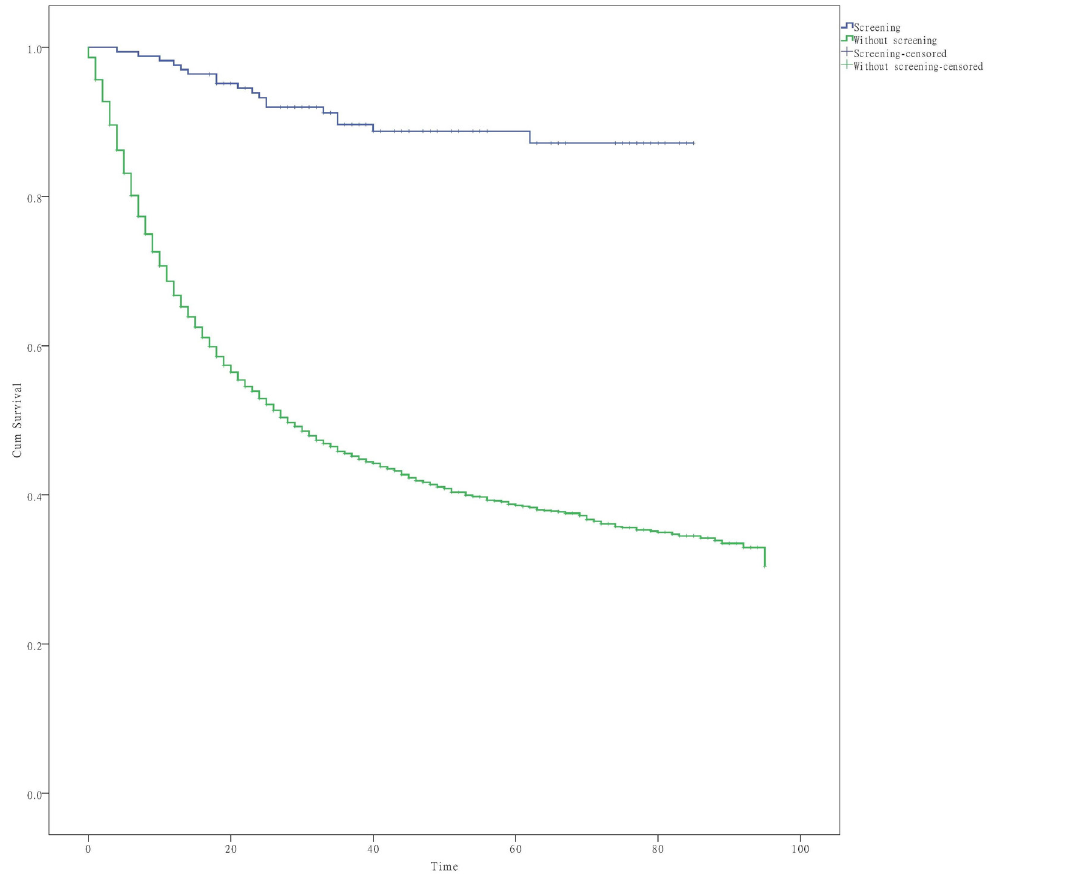
Fig 1. Survival curves of patients participating/not participating in the endoscopic screening